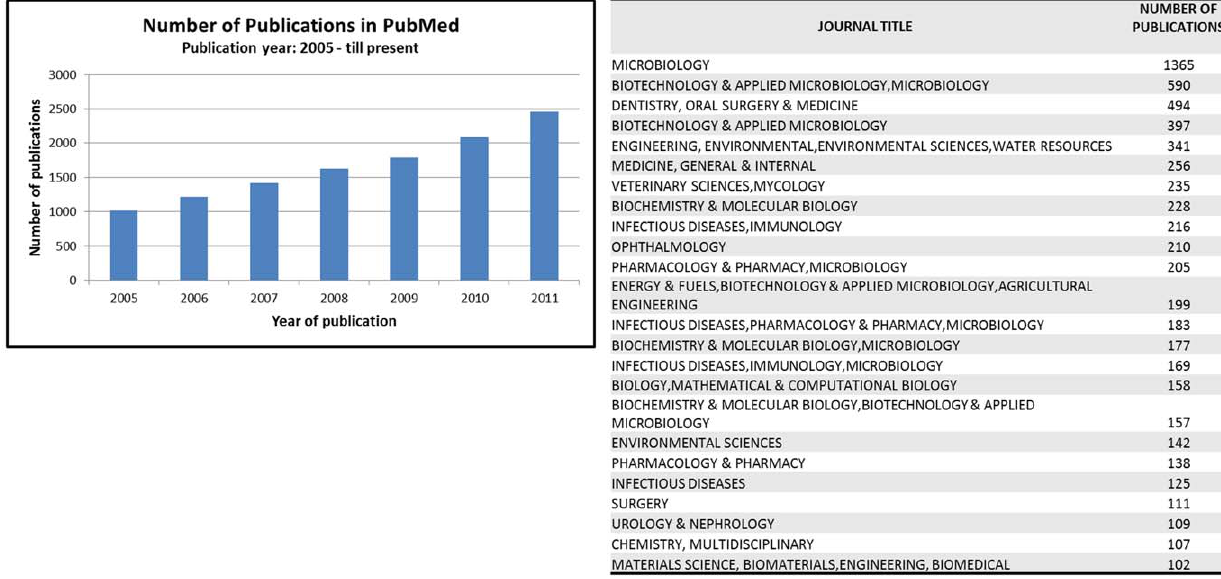
Figure 1. General statistics concerning publications on biofilms. The plot shows the publication rate from 2000 to 2011, and the table indicates the main scope of the top 25 journals that are publishing works about biofilms.